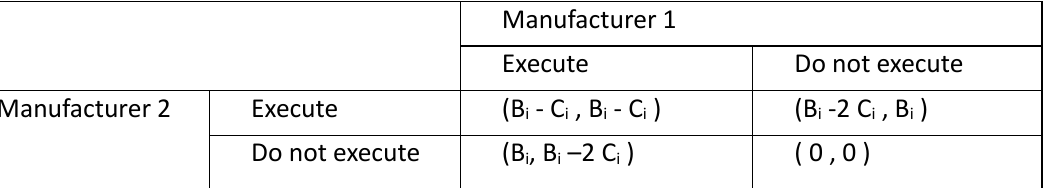
Table 1. Reputation Game Model of two